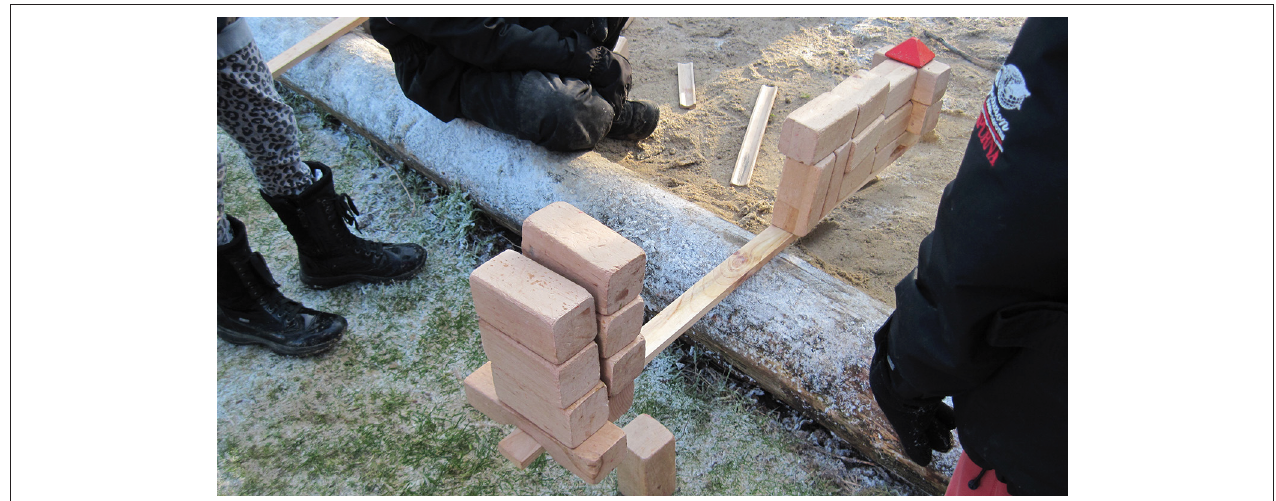
FIGURE 3 | Example of category 2, pupils balancing wooden